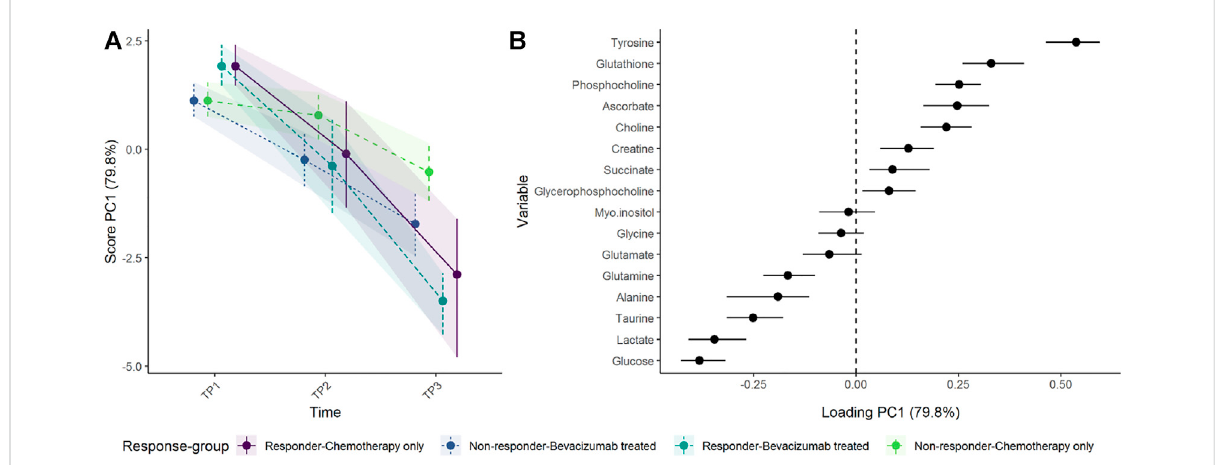
FIGURE 9 Time development of tumor biopsy metabolome before and during cancer treatment, in responders and non-responders as (A) scores and (B) loadings. Since participants were randomized to treatment but not response, the baseline levels are equal for all participants within each response groups. Non-responders receiving chemotherapy only show the smallest change of metabolome. The level of metabolites with high loading is increasing when the scores increase and vice versa